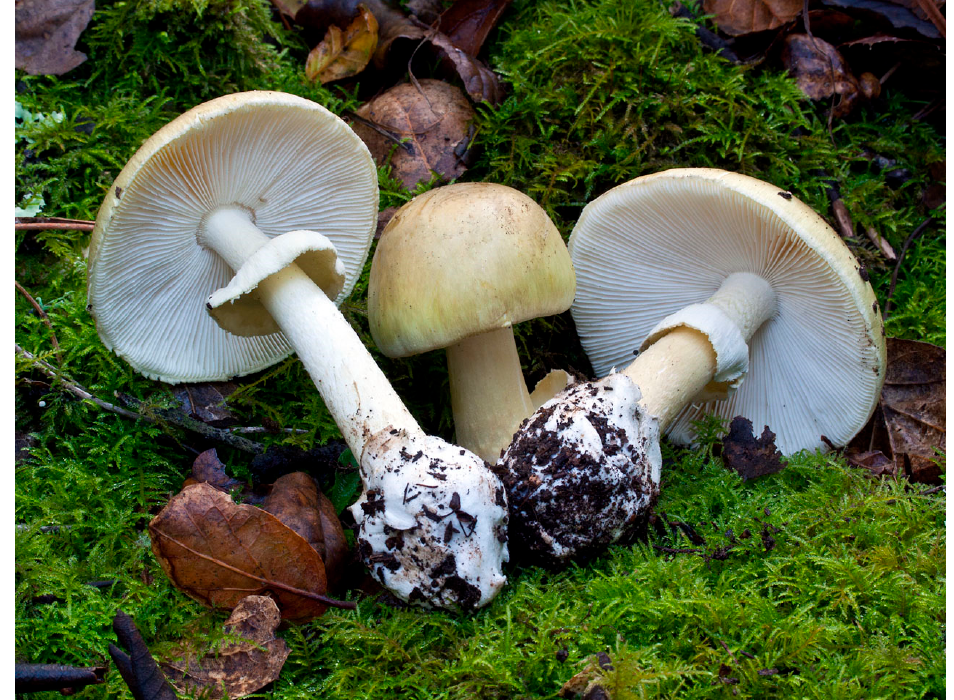
Figure 4. Amanita phalloides [79].